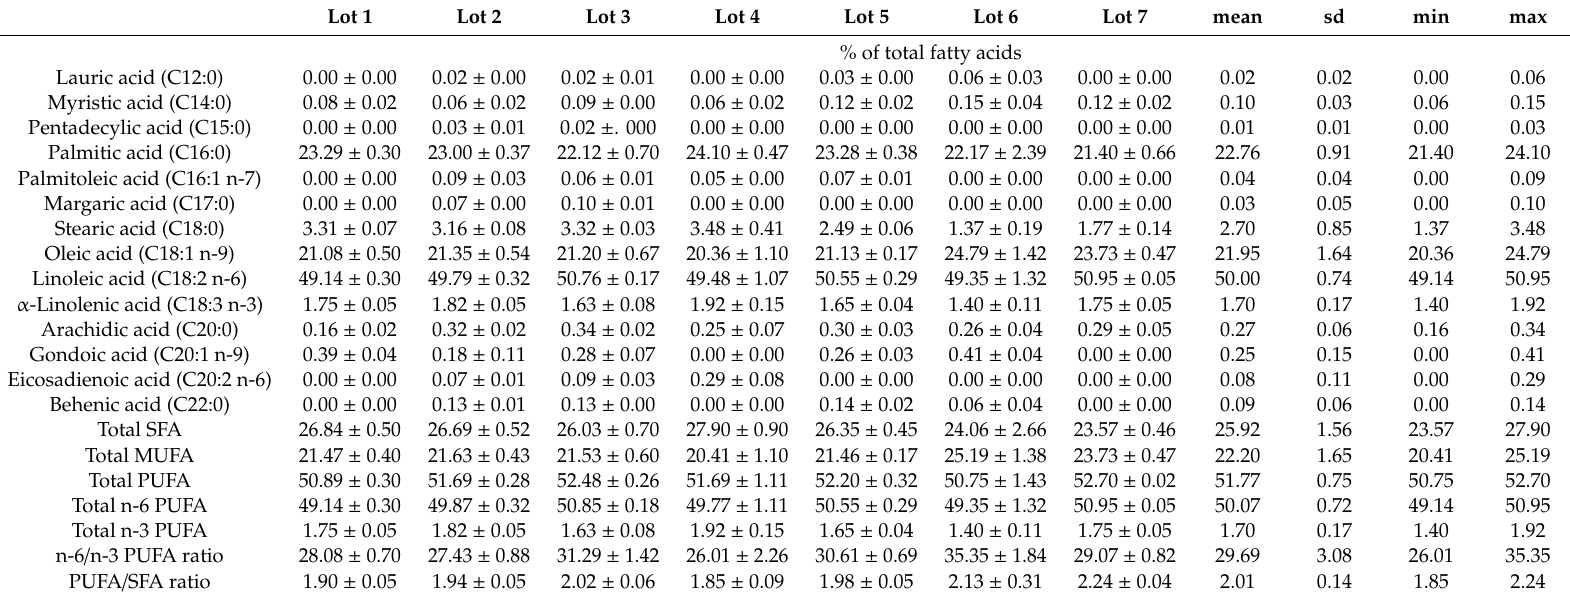
Table 5. Fatty acid profile of thin stillage from the dry-grind corn ethanol plant. Mean, standard deviation, and range of values observed over a one-year period (n = 7) *. Values are expressed as percent of total fatty